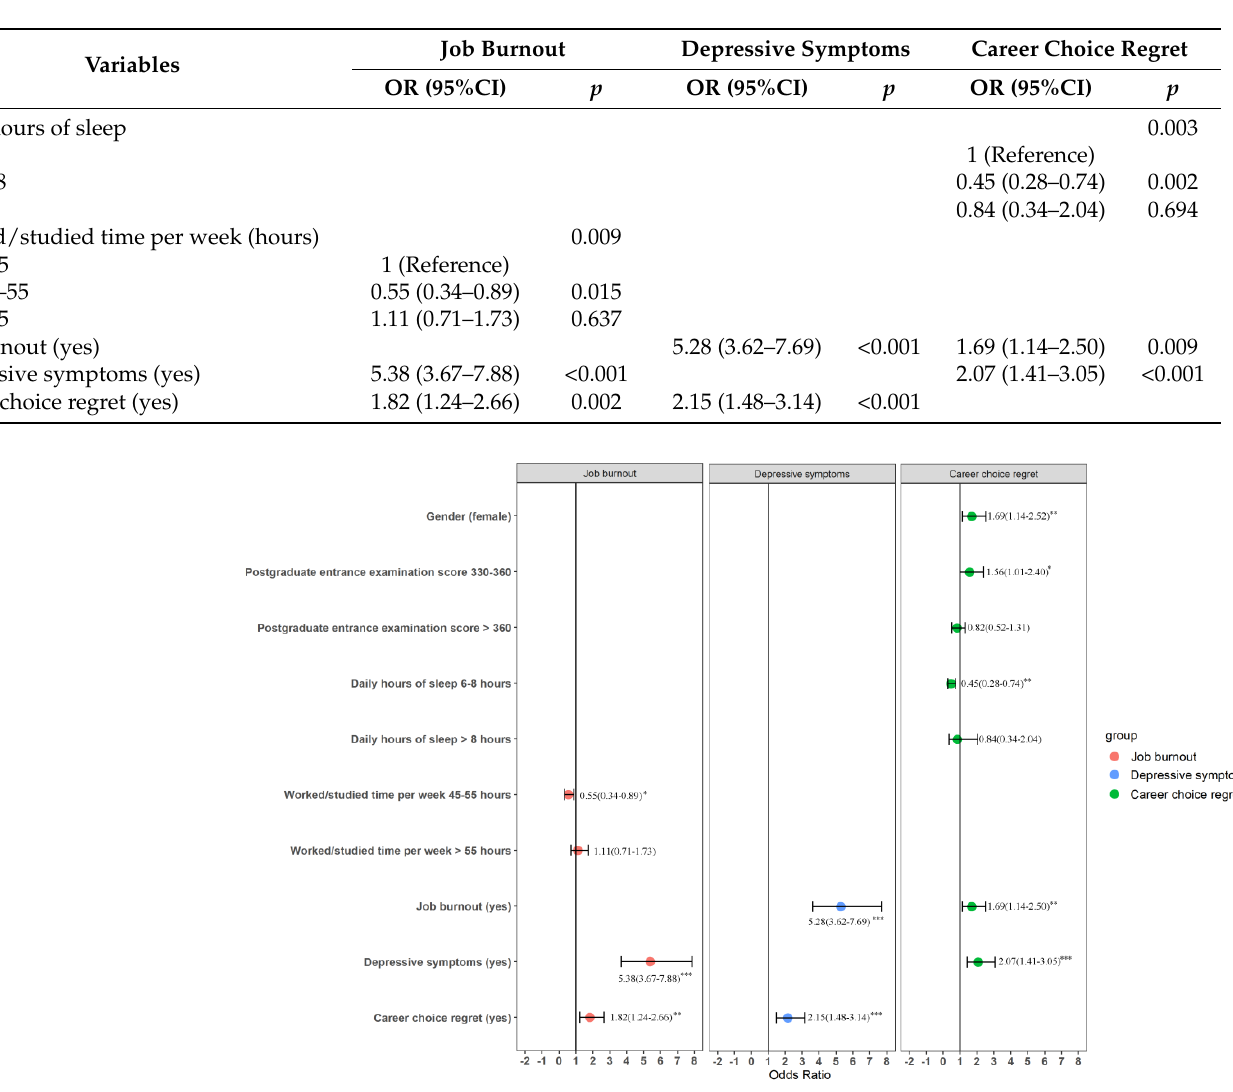
Table 5. Regression model two of job burnout, depressive symptoms, and career choice regret.